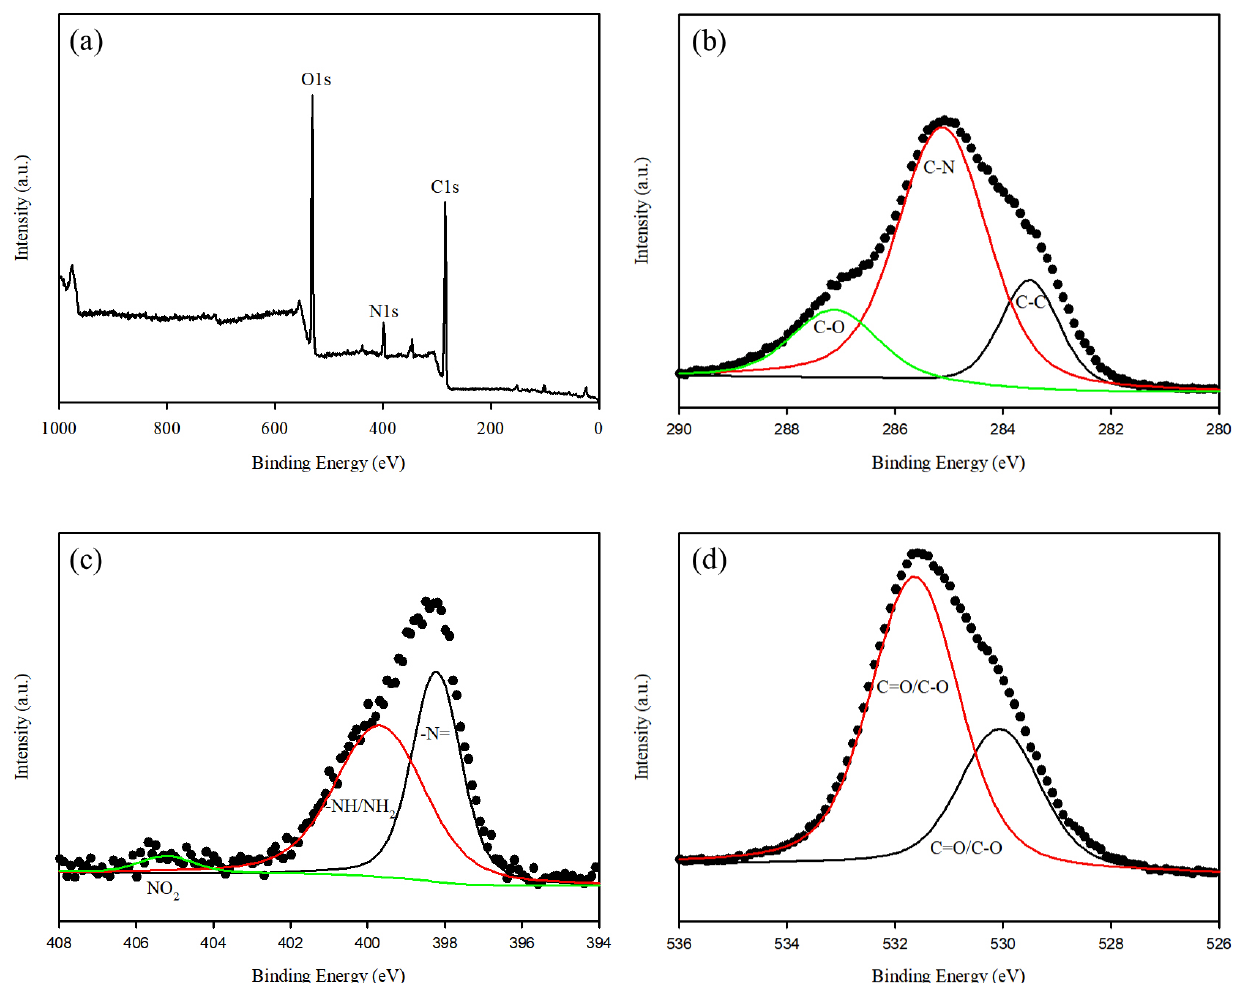
Figure 8. XPS spectra of WFD/SA-PEI bead: ( a ) wide scan and high-resolution XPS spectra of ( b ) C 1s, ( c ) N 1s and ( d ) O 1s.